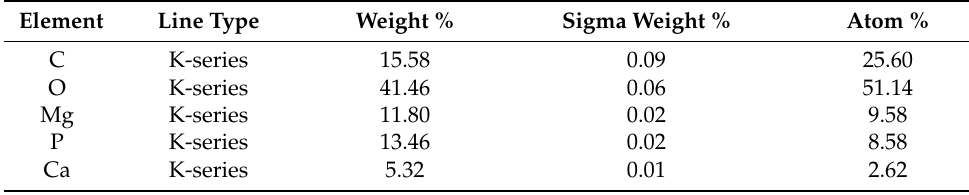
Figure 5. SEM image of sample after 6 months. Table 1. Total spectrum of map and distribution of elements after 1